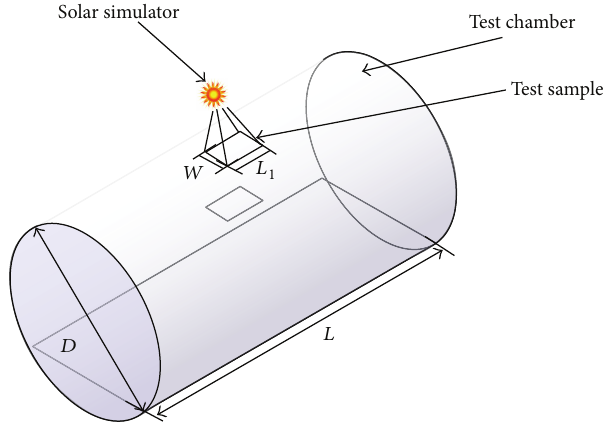
Figure 3: Test chamber and test